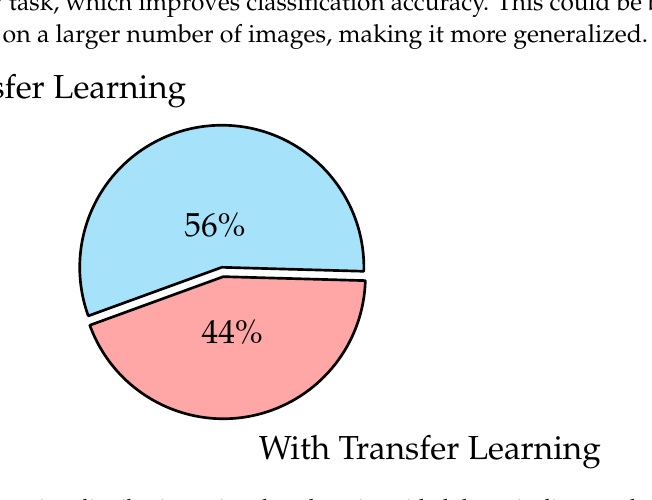
Figure 10. Transfer Learning distribution using deep learning aided thoracic diseases detection in the recent years.